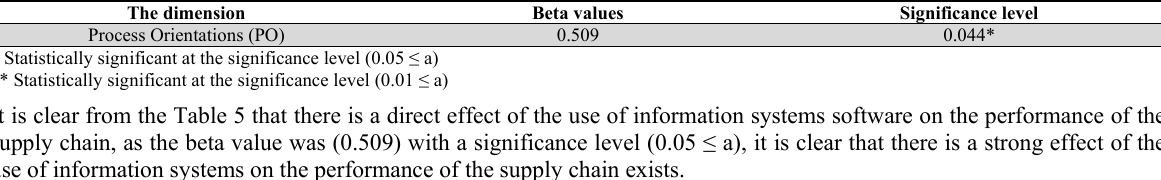
Table 4 values indicate an indirect effect of the dimensions of big data analysis (Planning, Procuring, Manufacturing, Deliv- ering) beta values reached (0.159, 0.247, 0.115, -0.023), respectively with a significant level (0.05 ≤ α ). Planning, Procuring and Manufacturing dimensions show a positive indirect effect whereas Delivering indicates an indirect negative insignificant effect. Given the above results, the alternative hypothesis is accepted that there is an indirect statistical significance effect at (Planning, Procuring, Manufacturing, Delivering) in Saudi industrial companies.